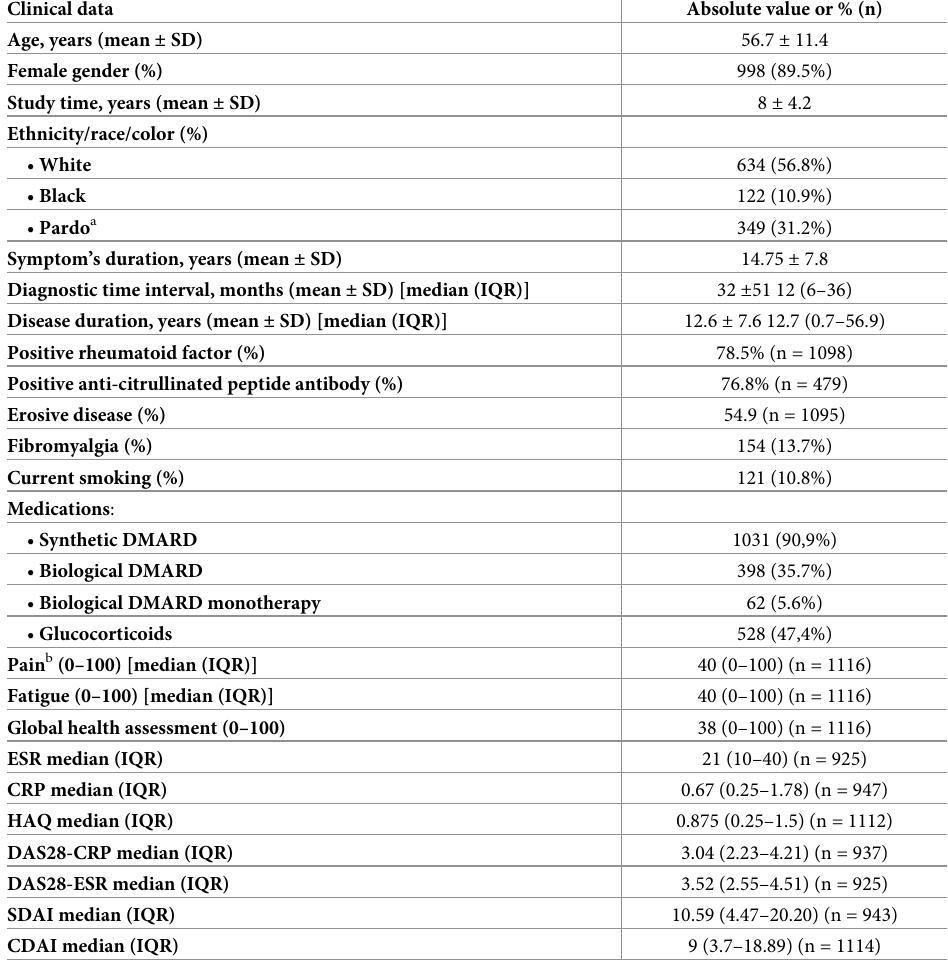
Table 3. Baseline clinical data of patients with RA in the REAL study (n = 1116). Clinical